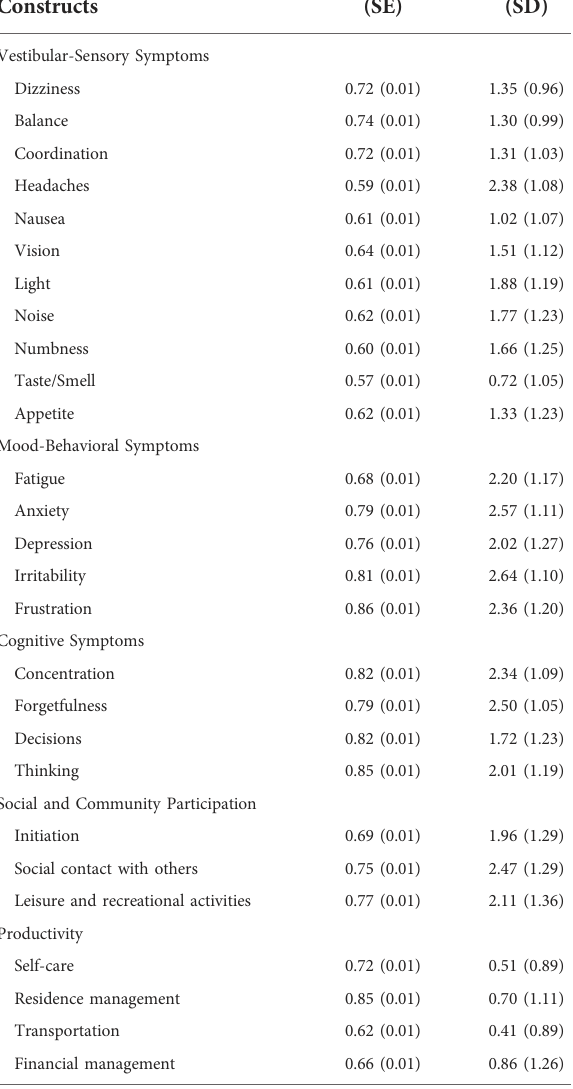
TABLE 2 Characteristics of the measurement component of the model ( n